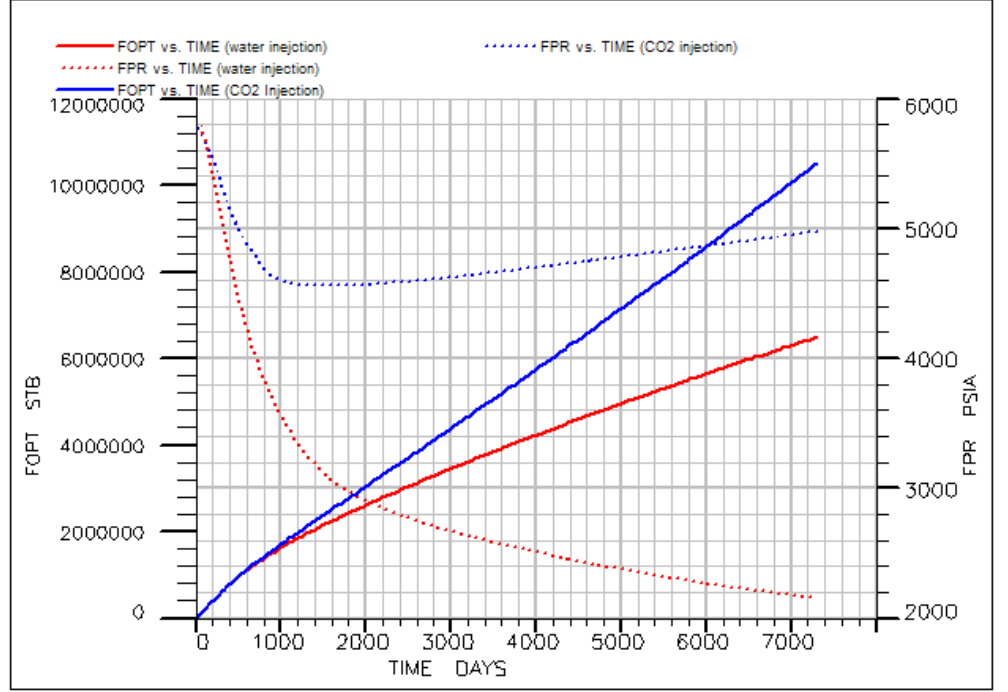
Figure 7. Comparison of oil recovery by water and miscible CO containing 100% CO ) for 20 years simulation run. Tick and dotted lines represent oil 2 recovery (STB) and the corresponding average field reservoir pressure (Psia),